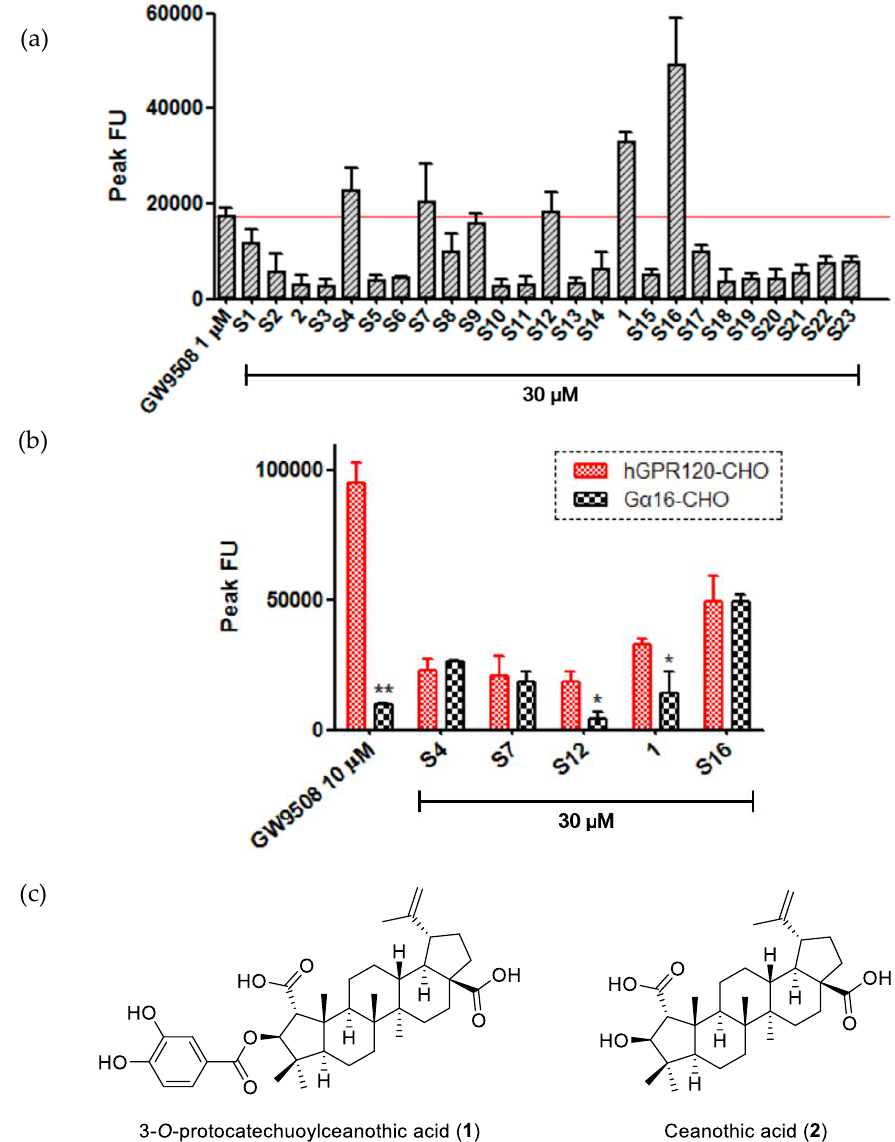
Figure 2. ( a ) GPR120 agonist activity of 25 triterpenoids isolated from Ziziphus jujuba . ([Ca 2 + ]i in hGPR120-CHO cells); ( b ) Comparison of GPR120 agonist activity between hGPR120-CHO cells and G α 16-CHO cells ([Ca 2 + ]i in hGPR120-CHO cells and [Ca 2 + ]i in G α 16-CHO cells). The statistical di ff erence between each group was analyzed using a Student’s t -test (* p < 0.05, ** p < 0.001, compared with hGPR120-CHO cells); ( c ) Structures of 3- O -protocatechuoylceanothic acid ( 1 ) and ceanothic acid ( 2 ).